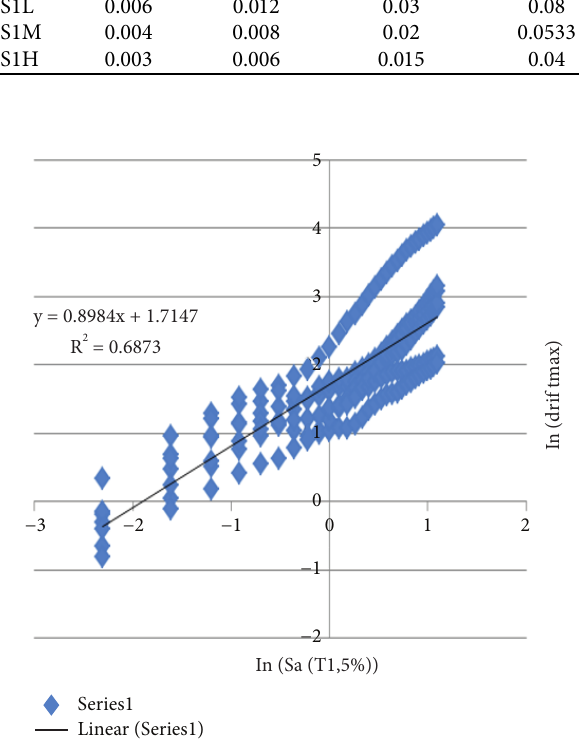
Figure 4: Maximum probabilistic seismic requirement for the relative displacement of floors.